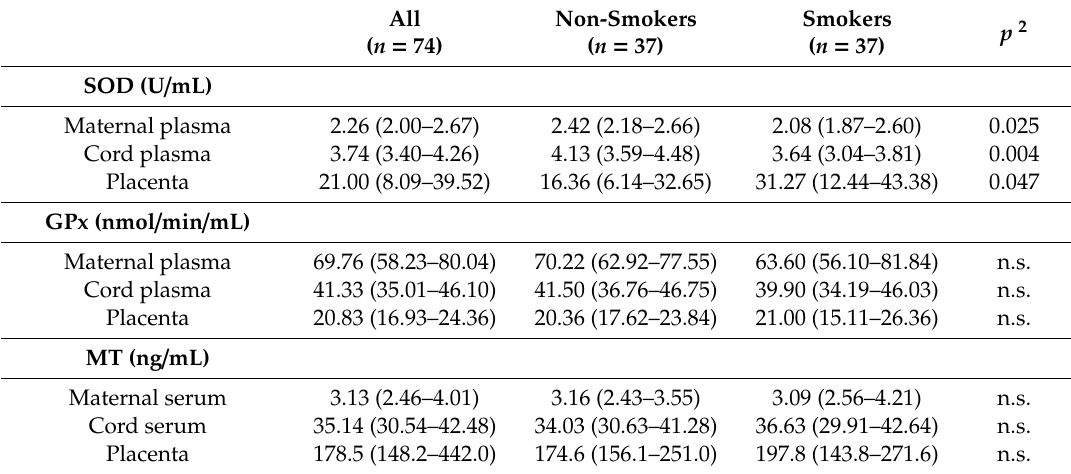
Table 2. Activity of antioxidant enzymes and MT concentrations in mother-newborn pairs 1